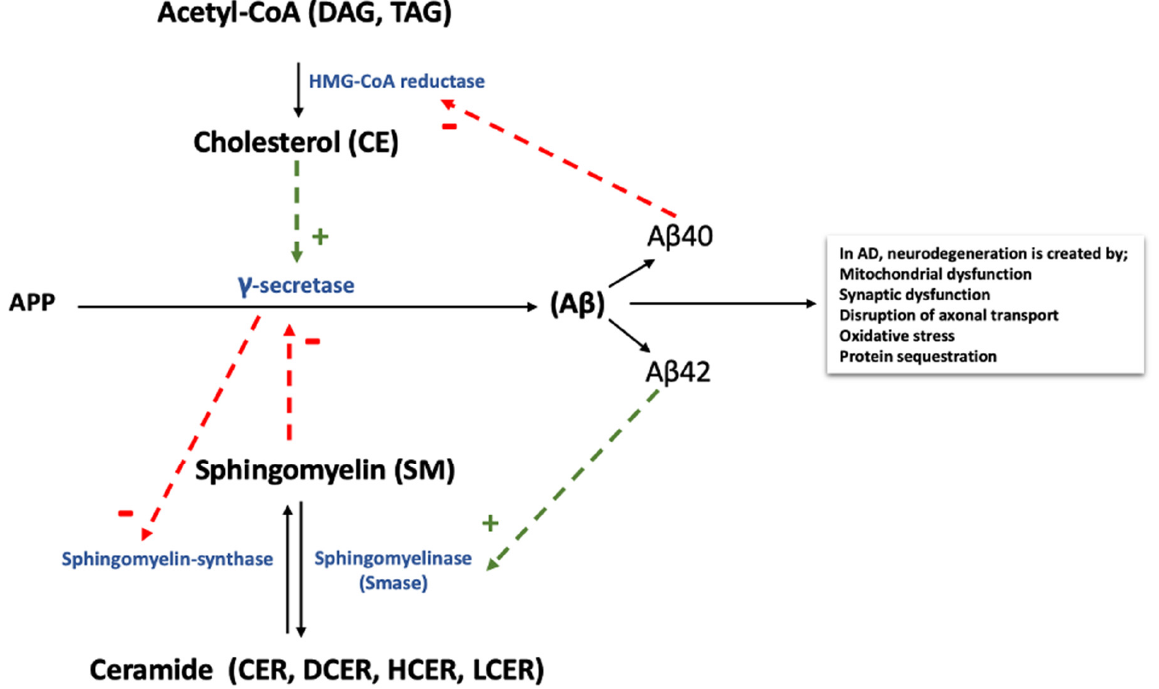
Figure 3. Proposed feedback modulation of A β synthesized from APP by the enzyme γ -secretase. Two main lipid groups, cholesterol and sphingomyelin, are closely related to A β production in AD. Cholesterol increases γ -secretase activity, which leads to elevated A β production. Conversely, A β downregulates cholesterol de novo synthesis from acetyl-CoA by inhibiting enzyme HMG-CoA reductase. Sphingomyelin inhibits γ -secretase activity, and in return reduced γ -secretase activity depresses sphingomyelin synthase activity. (Figure modified from the manuscript Zinser E.G. et al. BBA 2007;1768:1991–2001.) The related lipid species we measured are listed in the parentheses. Acetyl-CoA synthesized from fatty acids is released from diacylglycerol and triacylglycerols. Abbreviations: APP, amyloid precursor protein; CE, cholesteryl esters; CER, ceramides; DAG, diacylglycerols; DCER, dihydroceramides; HCER, hexosylceramides; LCER, lactosylceramides; SM, sphingomyelins; TAG, triacylglycerols.